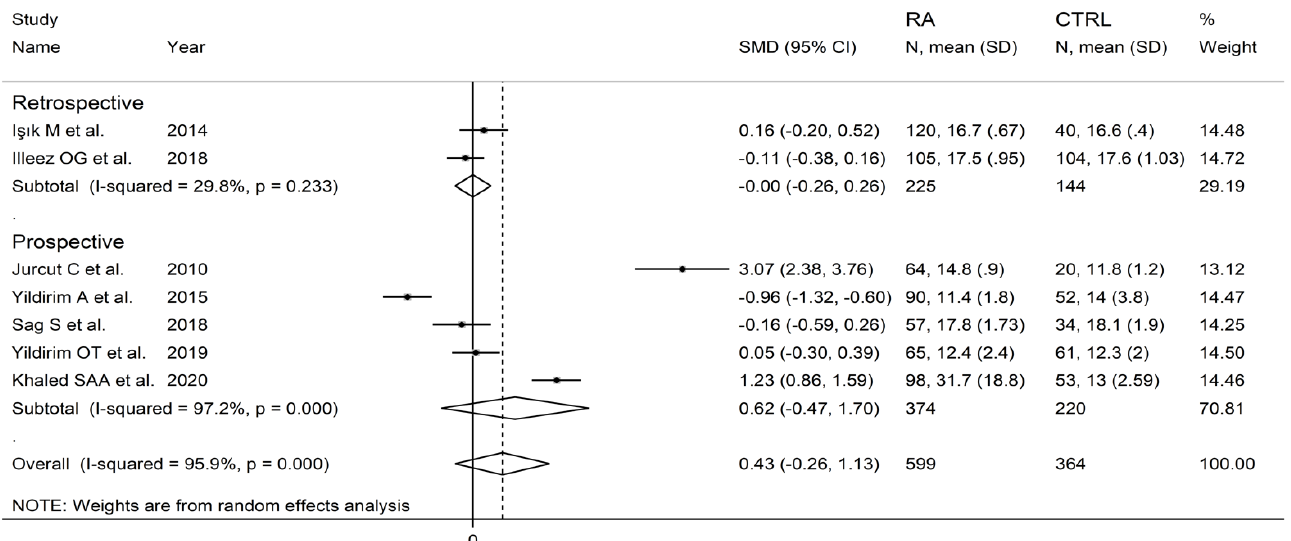
Figure 9. Sensitivity analysis of the association between the platelet distribution width and rheuma- toid arthritis. For each study, the displayed effect size (hollow circles) corresponds to an overall effect size computed from a meta-analysis excluding that study.